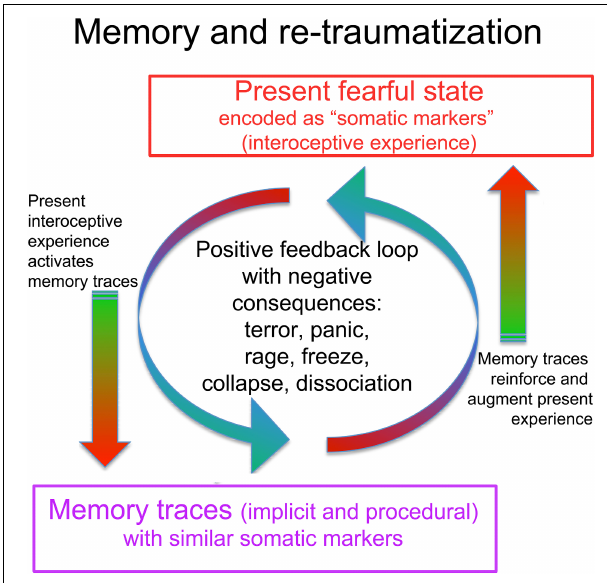
FIGURE 6 | The interaction of traumatic memory with the present state. A present fearful or stressful state is experienced in part as unpleasant interoceptive and proprioceptive feelings, including muscle tension, stomach tension, trembling, weakness, constriction, increased blood pressure (pounding pulse), decreased blood pressure (dizziness), increased or decreased heart rate, cold sweaty hands, hyperventilation, shallow breathing. Damasio terms these “somatic markers,” as they are bodily experiences of emotionally and viscerally activated states, consciously felt “markers” of subcortical states. These somatic markers may activate memory traces that contain similar feelings. Such trauma-related memory traces may be partly or wholly inaccessible to ordinary conscious recollection, being procedural or implicit rather than declarative and autobiographical. This means the person may not even be aware that old memories are being activated. Consciously recognized or not, the somatic markers connected to the old memories reinforce and augment the present fearful state in a runaway positive feedback loop, which can lead to terror, panic, rage, or shut-down. In response to these aversive experiences (whether triggered by a present situation, conscious memories, or implicit and procedural traumatic memories), the CRN mobilizes a defensive response; given the circumstances, the response is unlikely to succeed (unless carefully guided by a skilled therapist). Such renewed failure may further disorganize the system and add to the undischarged activation